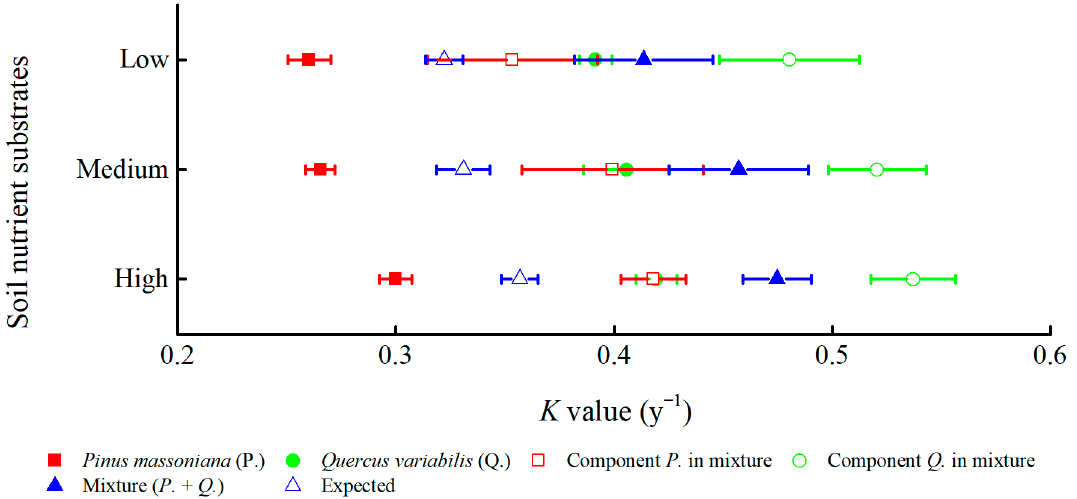
Figure 2. Effect of soil nutrient substrate on leaf litter decomposition (in terms of decomposition constant: k value). Values are the mean ± SE ( n = 3). The results of two-way ANOVA suggest significant effects from the soil nutrient substrate (F (2,18) = 4.142, p = 0.033) and leaf litter type (F (2,18) = 73.533, p < 0.001) on the decomposition constant.